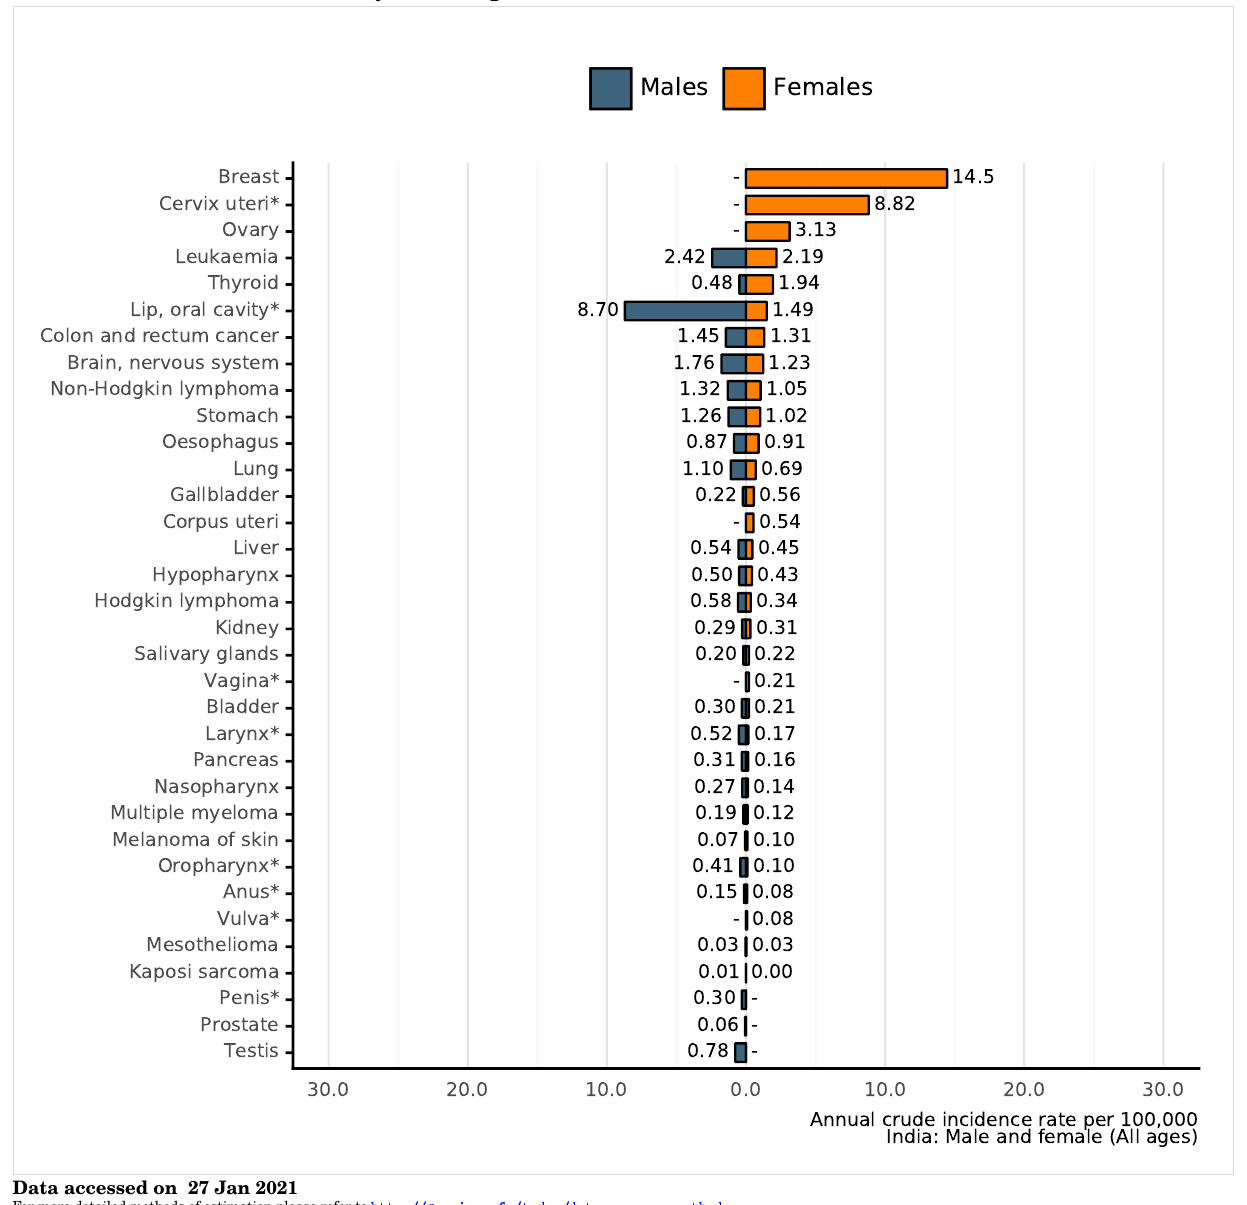
Figure 5: Comparison of HPV related cancers incidence to other cancers among men and women 15-44 years of age in India (estimates for